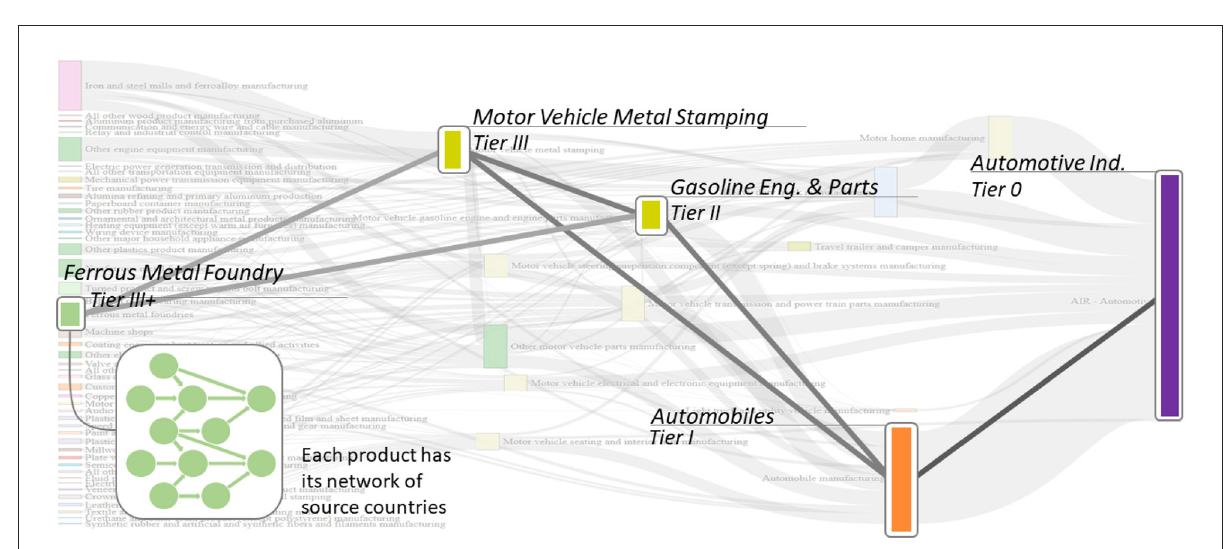
FIGURE4 More populated product dependency overview from EM framework for Port of Valencia with inputs and outputs using Figure